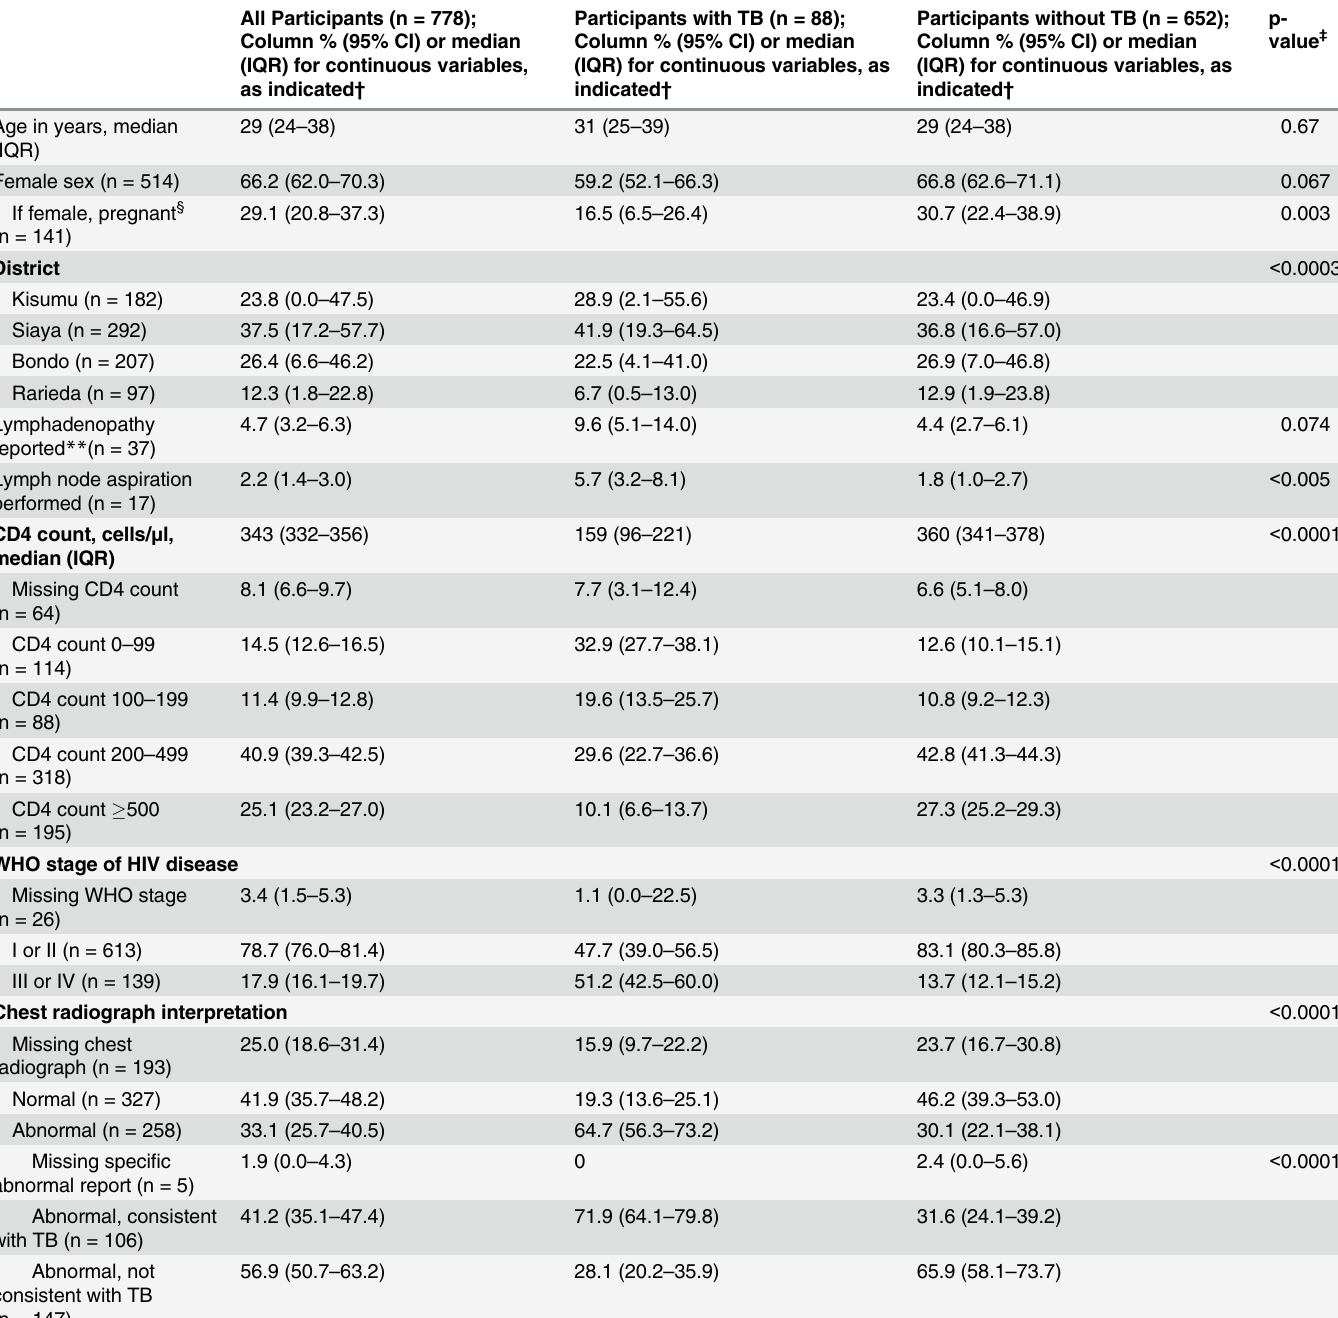
Table 1. Demographic and clinical characteristics of enrolled participants, stratified by tuberculosis (TB) diagnosis * . All Participants (n = 778); Column % (95% CI) or median (IQR) for continuous variables, as indicated †